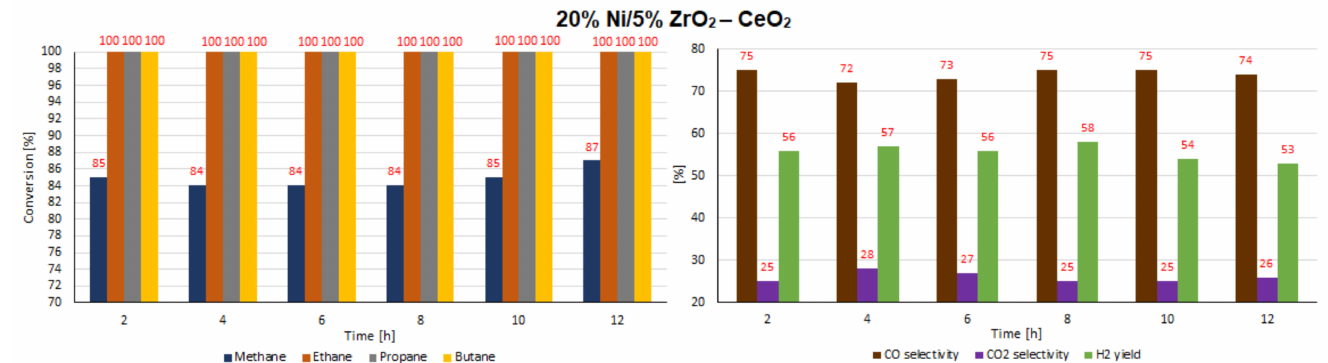
Figure 24. Results of the time-on-stream catalytic tests performed over 12 h of the OSR of LNG reaction on a 20% Ni/5% ZrO 2 –CeO 2